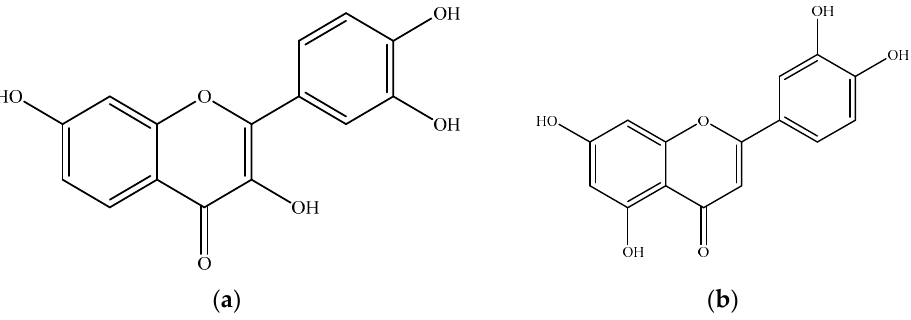
Figure 1. Chemical structures of ( a ) fisetin and ( b ) luteolin (as the internal standard for HPLC analysis).